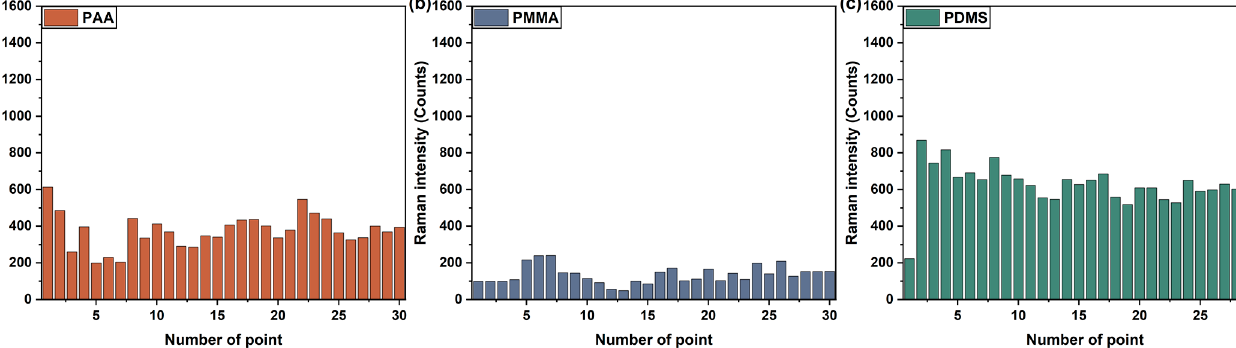
Figure 5. Raman intensity collected from the random 30 points obtained using the ( a ) PAA, ( b ) PMMA and ( c ) PDMS polymer film-coated SERS gas sensor for phenethyl alcohol gas detection.